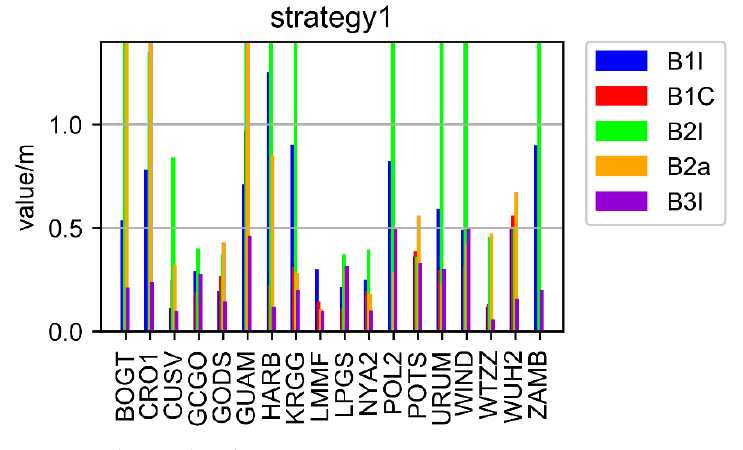
Figure 7. The results of Strategy 1.